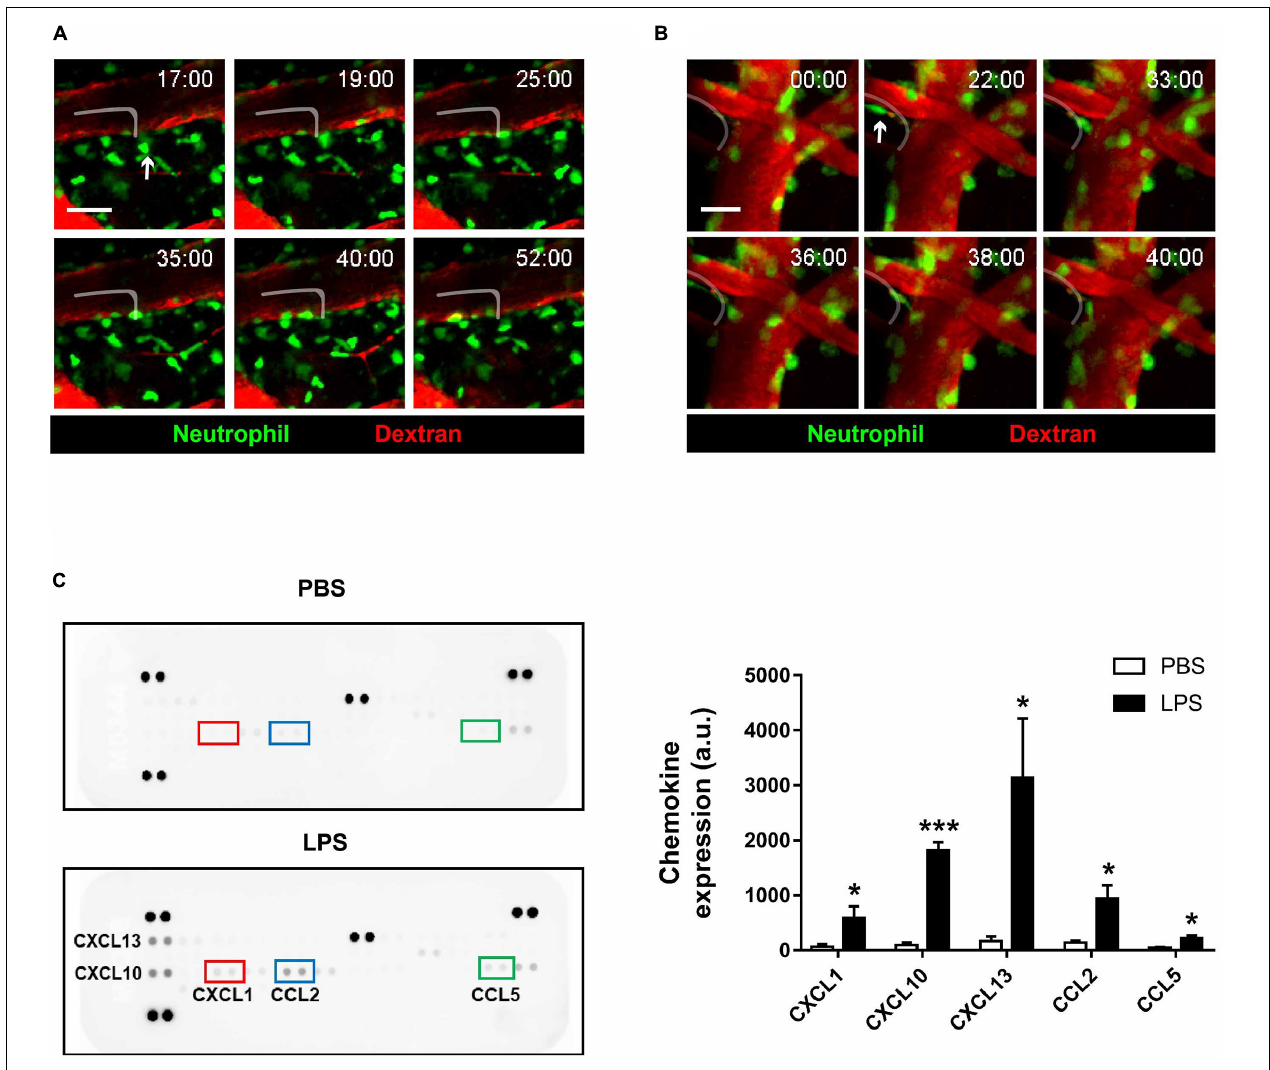
FIGURE 4 | Reverse-transendothelial migration of neutrophils in inflamed brain parenchyma. LysM GFP / + mice were used to visualize neutrophils (green) during neuroinflammation. Texas red dextran was i.v. injected to stain blood vessels (red). (A) A series of representative time-lapse images showing neutrophil crawling along the perivascular region in inflamed brain parenchyma. Tracking of neutrophil (white line). Scale bar, 50 µ m (see Supplementary Video 7 ). (B) A series of representative time-lapse images showing reverse-transendothelial migration of neutrophils from brain parenchyma into blood vessels. Tracking of neutrophil (white line). Scale bar, 20 µ m. (C) Brain chemokine array results demonstrating altered expression levels of chemokines following LPS injection. Data indicate mean ± SEM using Student’s t -test (* p < 0.005, *** p < 0.001). Three independent experiments were